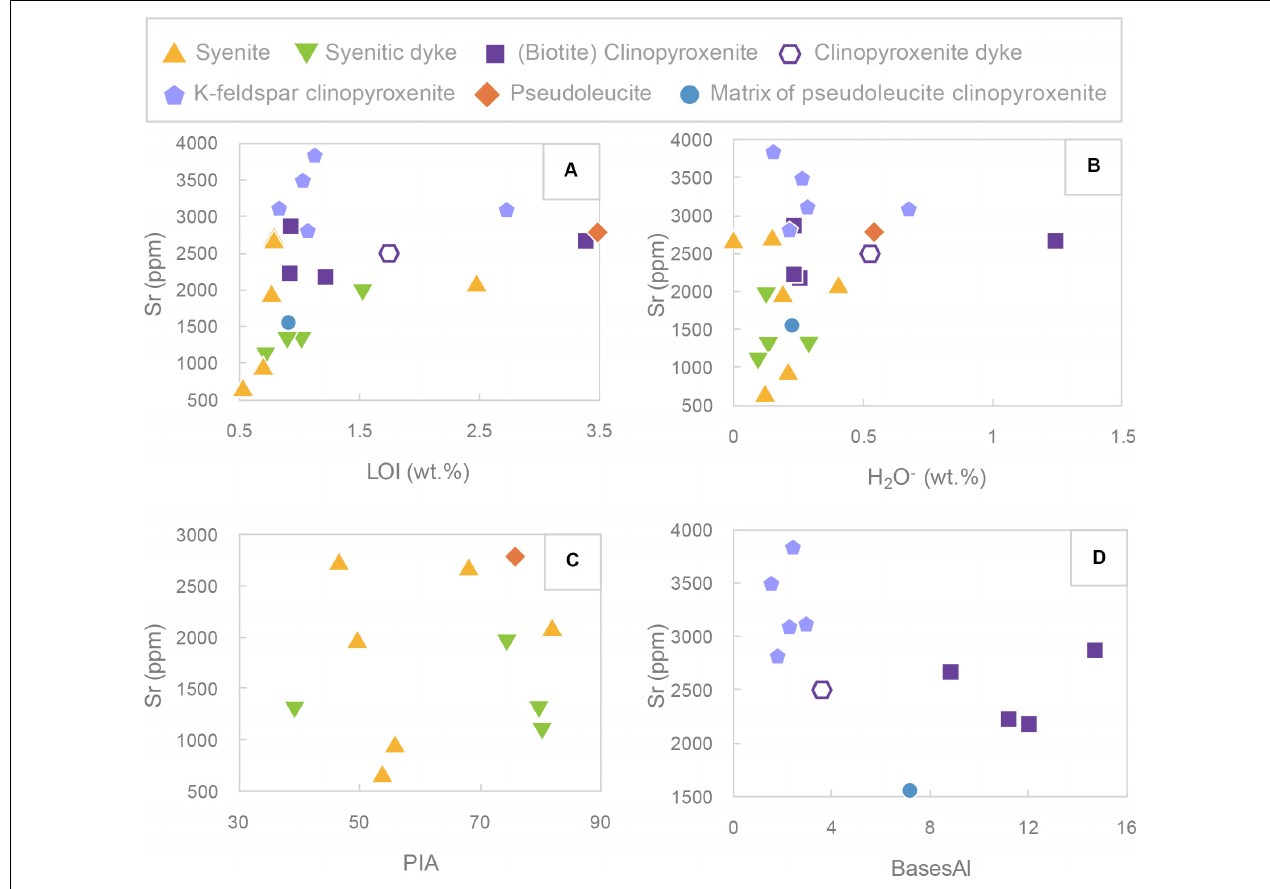
FIGURE 13 | Sr vs. (A) LOI (wt.%), (B) H 2 O - , (C) Plagioclase Index of Alteration (PIA; Fedo et al., 1995) and (D) Bases to Alumina ratio (BasesAl; Coleman, 1982) diagrams to evaluate the degree of chemical alteration for Yaojiazhuang